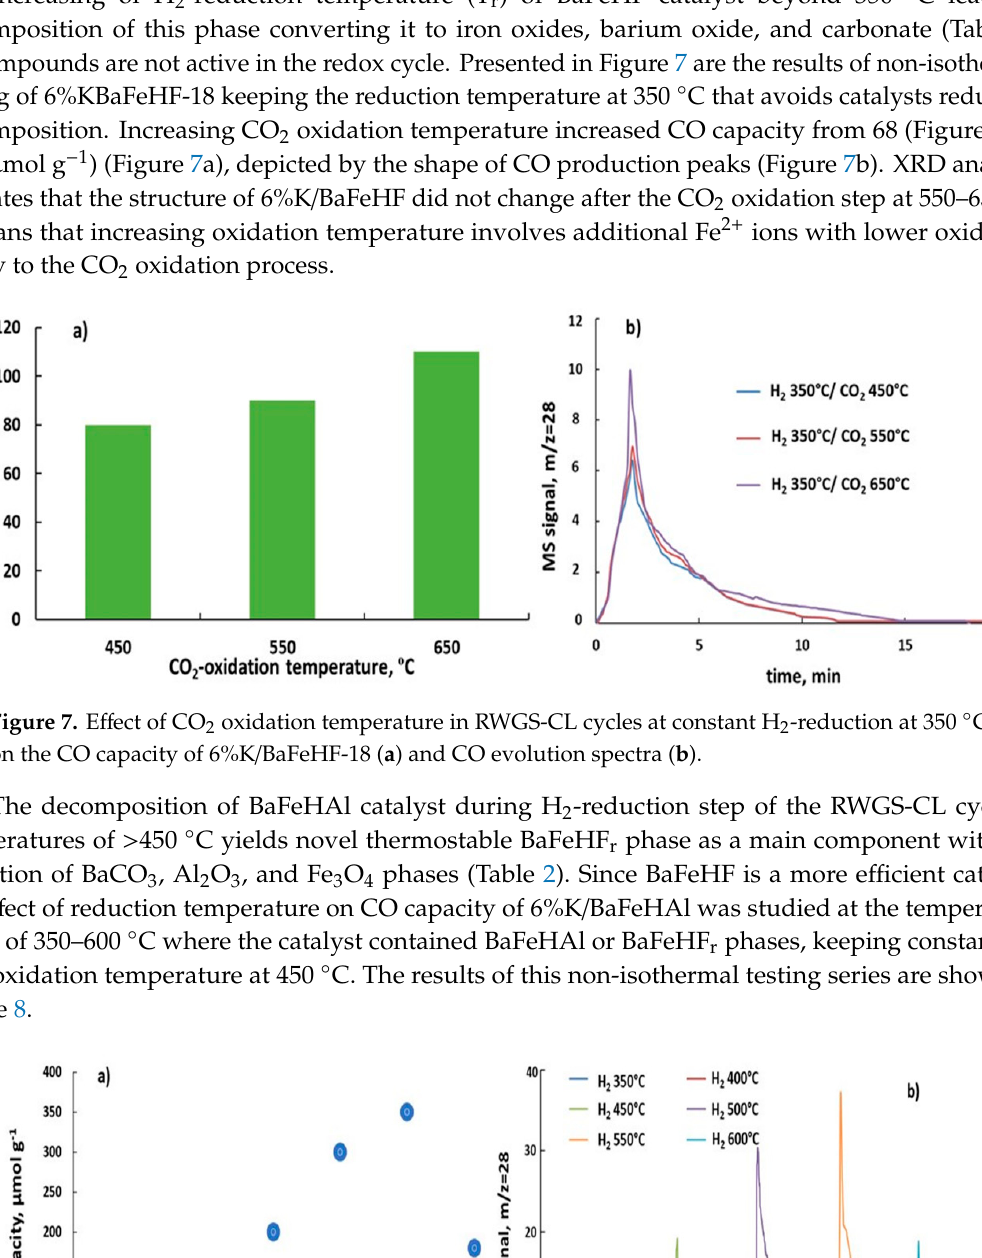
Figure 6. Comparison of the CO capacity in RWGS-CL of as-prepared and K-promoted BaFeHAl and BaFeHF at 350 °C.